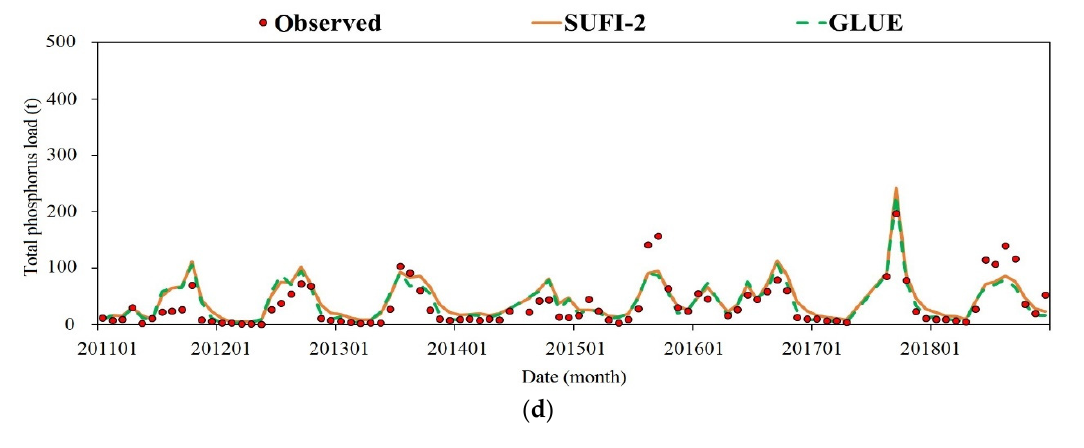
Figure 3. Simulation results of ( a ) total nitrogen load in calibration period and ( b ) total nitrogen load in verification period and ( c ) total phosphorus load in calibration period and ( d ) total nitrogen load in verification period at the outlet (USGS02295637). Table 4. Evaluation indexes of the total nitrogen and total phosphorus load simulation results.